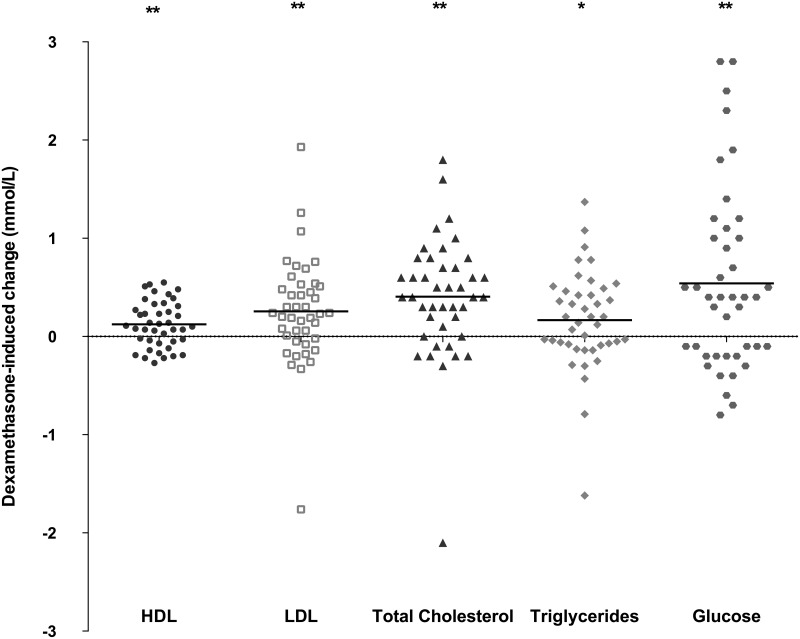
Lipids and glucose.Dexamethasone-induced change in HDL, LDL, total cholesterol, triglycerides, and glucose (mmol/L) from T1 to T2. * = P<0.05 and ** = P<0.01 (Student’s paired t-test). The horizontal lines indicate the median change.